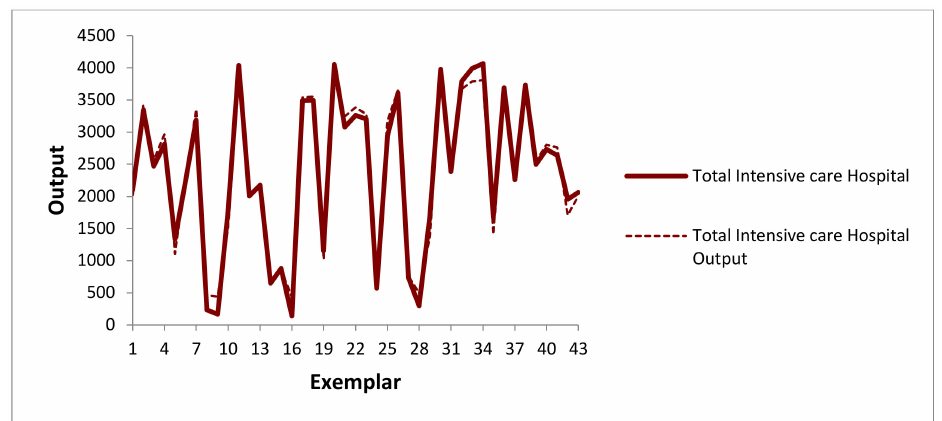
Figure A1. Predicted values by ANN algorithm vs. training data set.